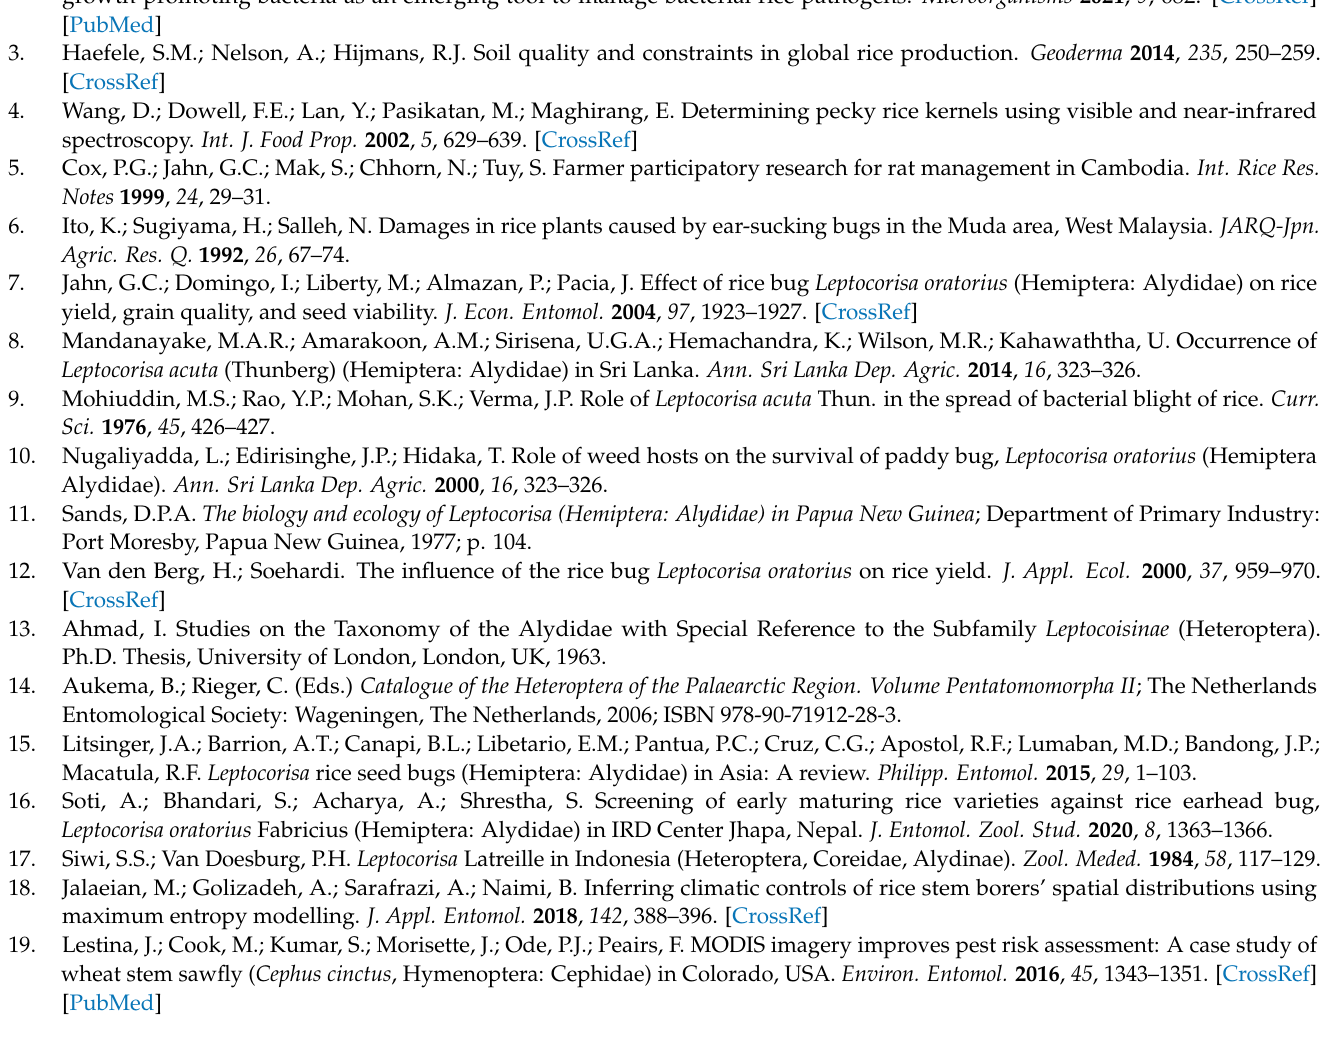
climate, Figure S9: Potential distribution of L. oratoria in the world in 2081-2100, Table S1: Pearson correlation matrix of environmental variables in L. chinensis , Table S2: Pearson correlation matrix of environmental variables in L. acuta , Table S3: Pearson correlation matrix of environmental variables in L. oratoria